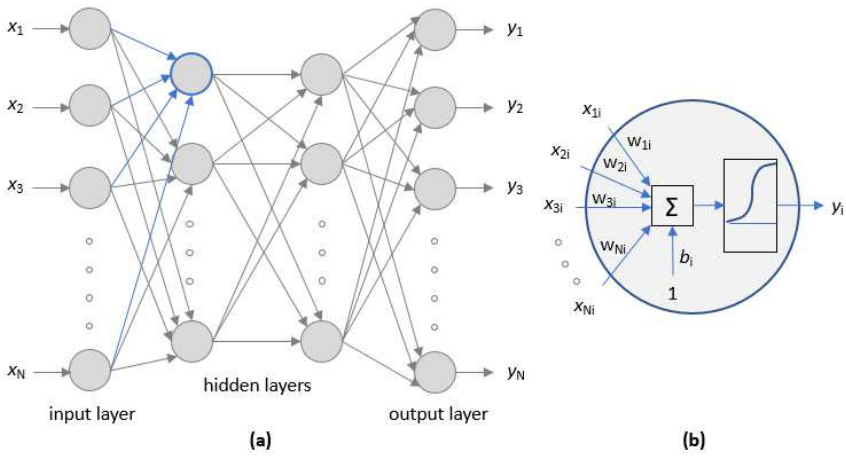
Figure 2. Artificial neural network: ( a ) layers structure, ( b ) detail of a